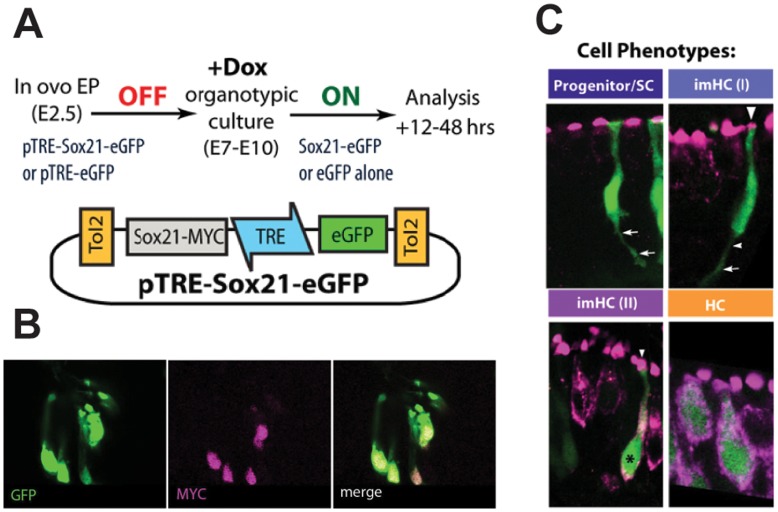
Tol2 system for Dox-inducible gene expression and classification of cell phenotypes.(A) The pTRE-Sox21-eEGFP Dox-inducible expression vector and experimental design for testing the effects of Sox21 induction at late stages of ear development. (B) MYC-tagged Sox21 was detected in the nuclei of all eGFP positive cells. (C) Classification of eGFP-positive cells into 4 phenotypes: uncommitted progenitor/support cell, in which otoferlin and HCA are not expressed, and with a cytoplasmic process contacting the basal lamina (arrows); immature hair cell type I (imHC (I)) in which HCA is present (arrowhead) but otoferlin is not, and which can exhibit a basal cytoplasmic process (arrows); immature hair cell type II (imHC (II)), with an elongated cell shape and both otoferlin and HCA expressed; Mature hair cell (HC), with a flask-shaped cell body and both otoferlin and HCA expressed.